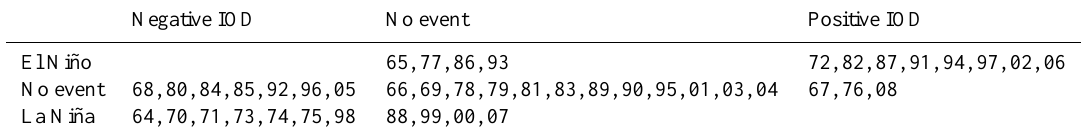
Table 2. Classification of years when El Niño or La Niña (presence during the second part of the year) and/or a positive or negative Indian Ocean Dipole occurred (when DMI index exceeds 1 σ above or below zero during the last part of the year for at least 2 or 3